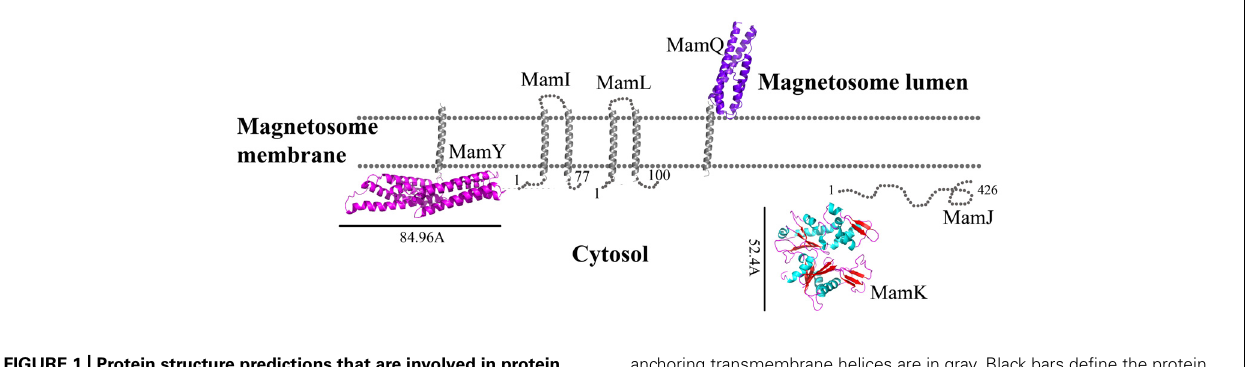
anchoring transmembrane helices are in gray. Black bars define the protein size in angstroms. M. gryphiswaldense MSR-1 MamA structure was determent by X-ray